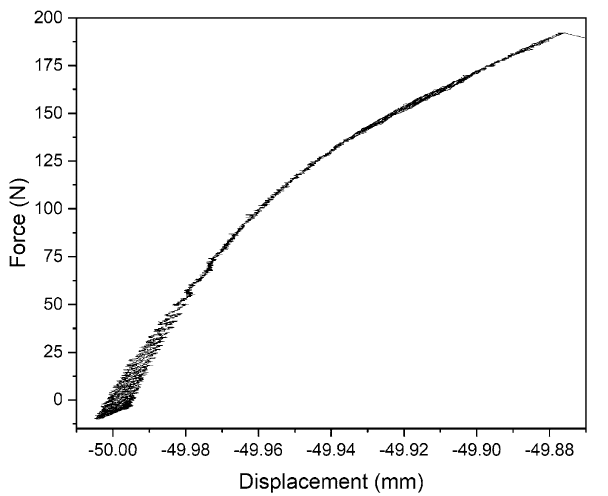
Figure 5. Tensile testing of the m-cresol bond, showing a force of ~ 192 N required to break the bond, with the film stretching a length of ~ 120 µm.